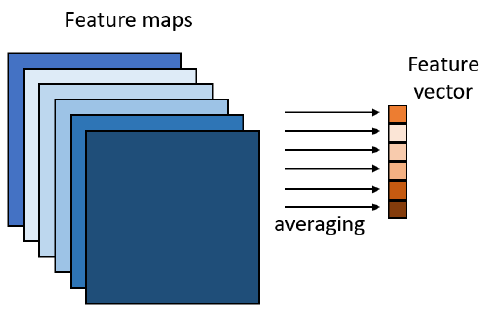
Figure 5. Illustration of global average pooling. It takes the average of each feature map to compile a new feature vector.